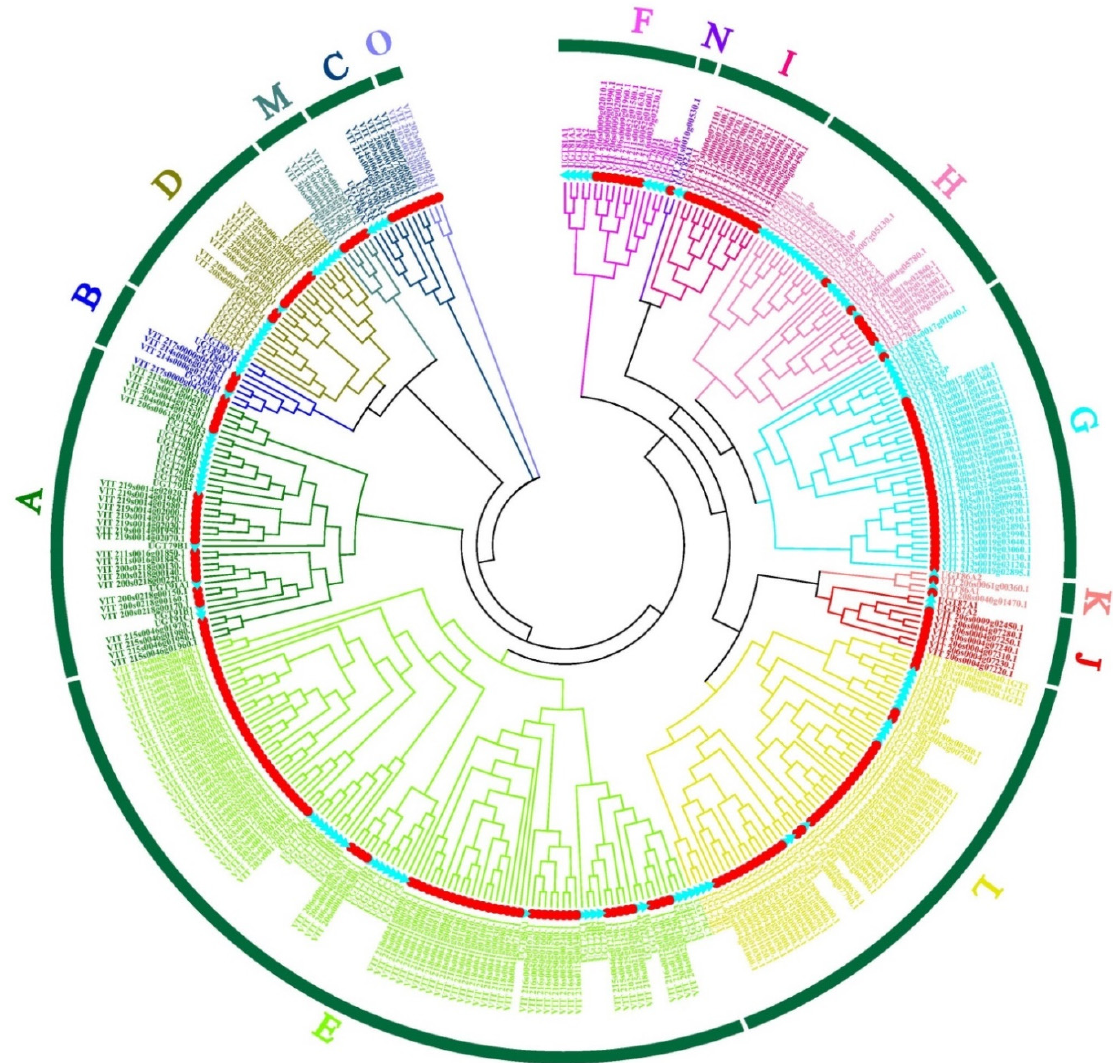
Figure 1. Phylogenetic analysis of UGT gene families between V. vinifera and A . thaliana . The maximum likelihood tree